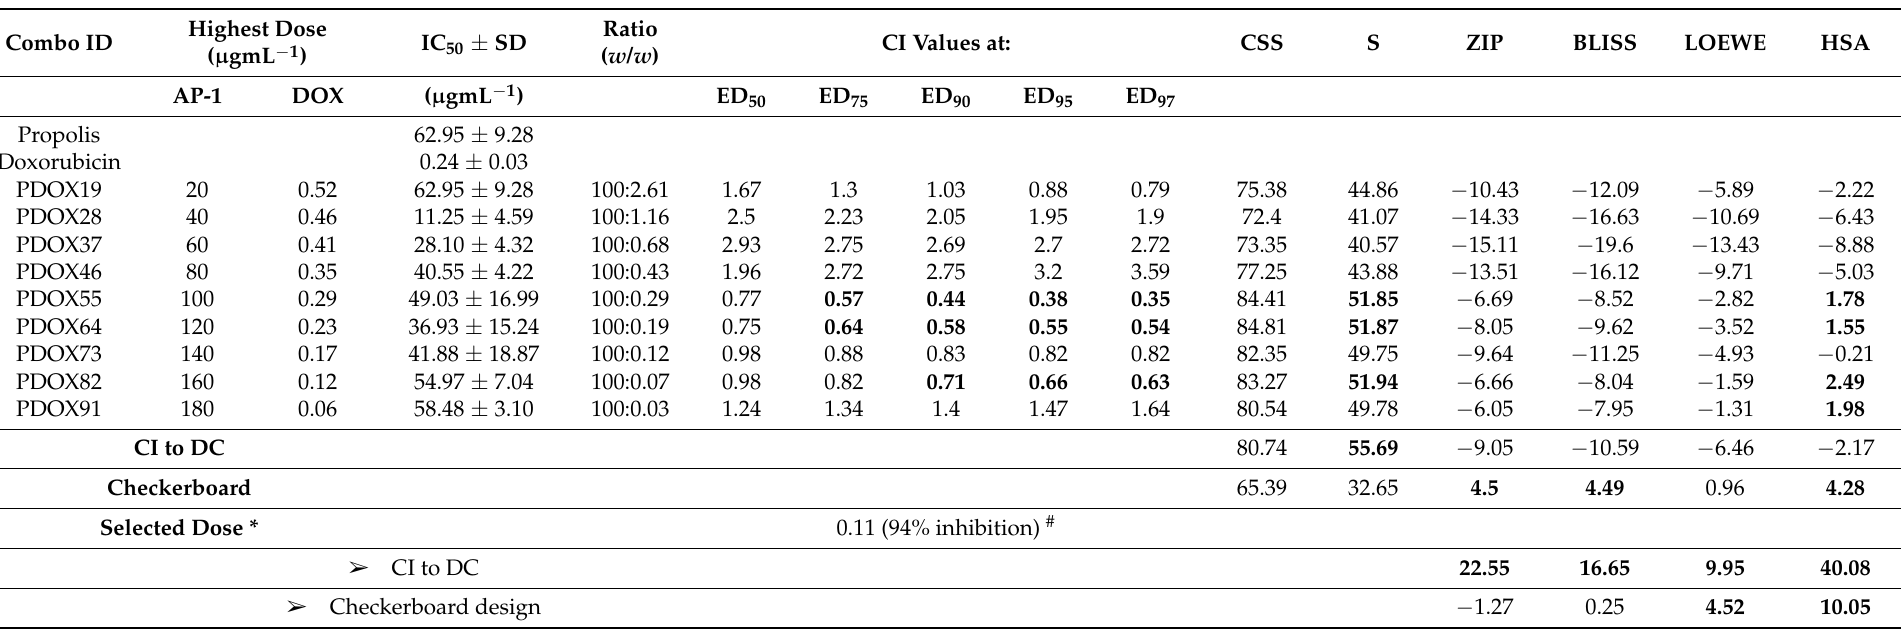
Table 1. Synergy quantitation of AP-1 and DOX combinations against the MCF7 breast adenocarcinoma